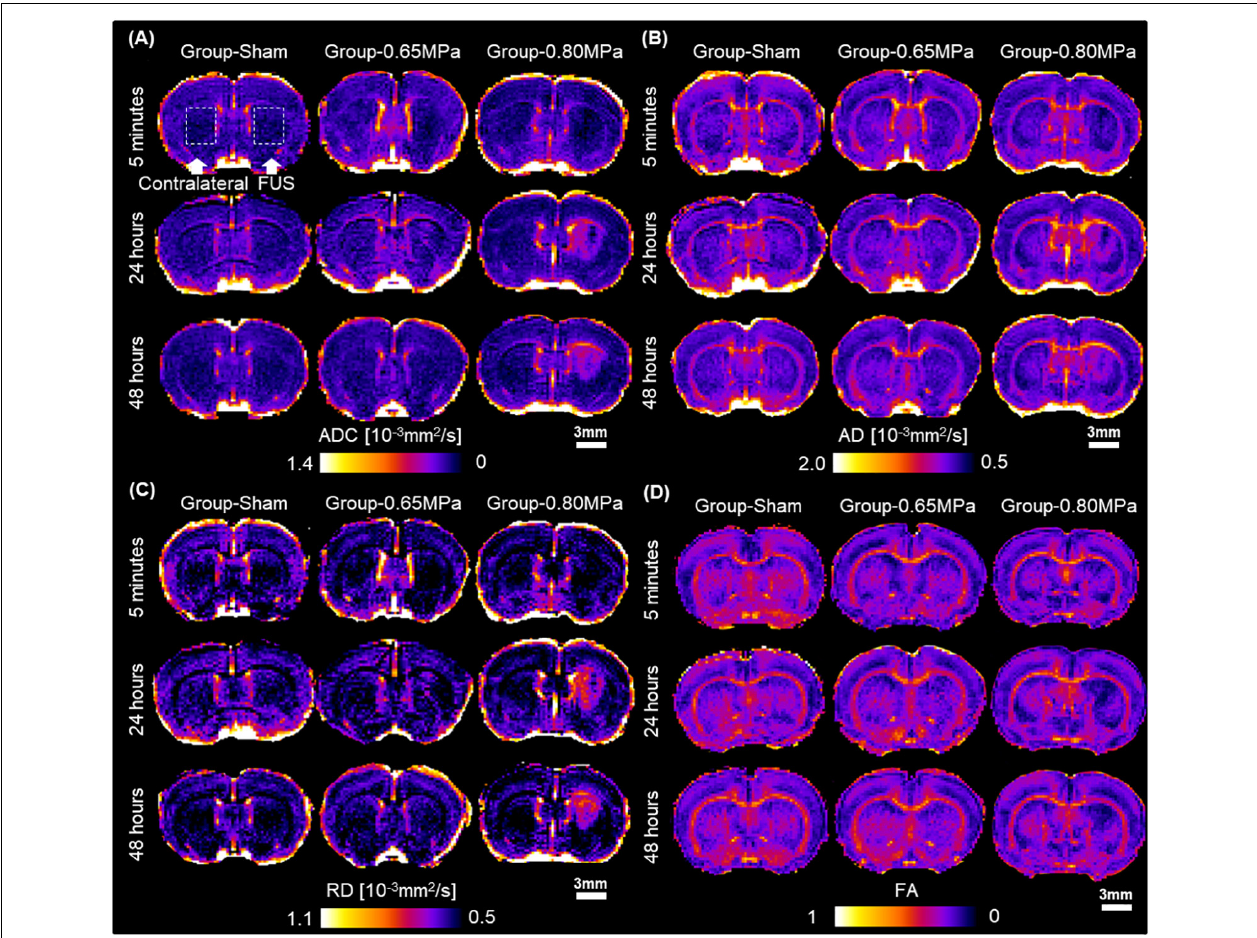
FIGURE 3 | DTI measures after FUS–BBBD. (A) Representative maps of apparent diffusion coefficient (ADC), (B) axial diffusivity (AD), (C) radial diffusivity (RD), and (D) fractional anisotropy (FA) at caudate putamen. Scale bar: 3 mm.